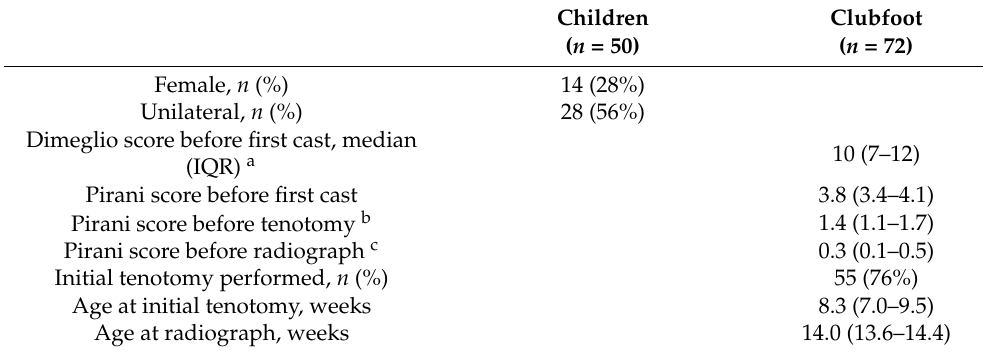
Table 1. Characteristics of the children and feet of children treated according to Ponseti.